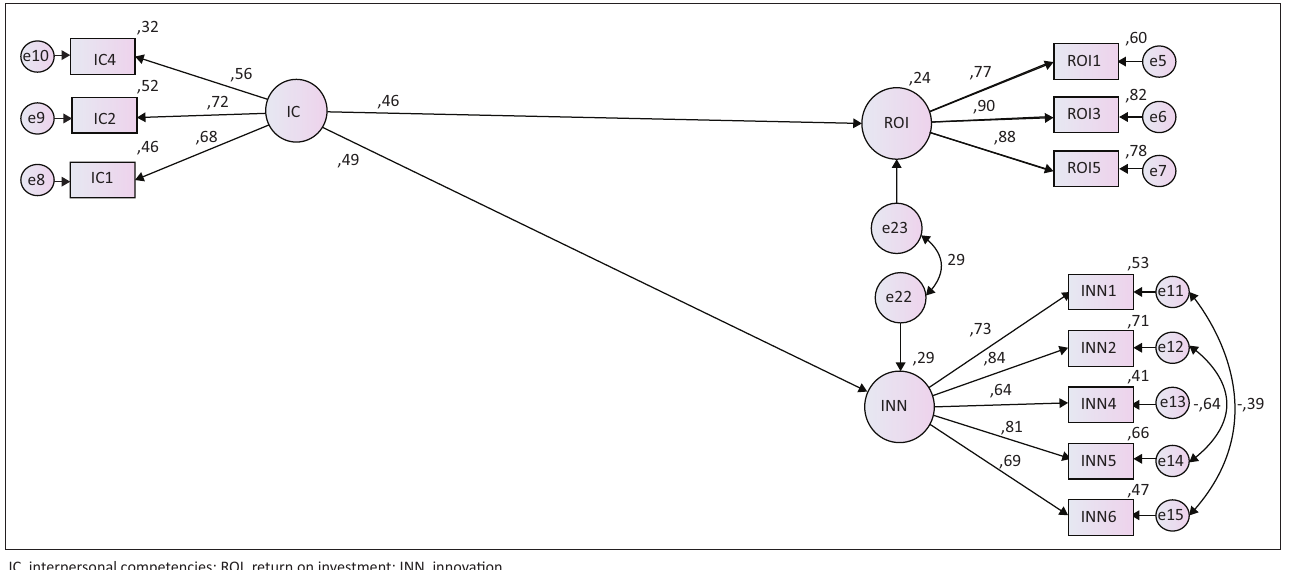
FIG URE 2: The structural TABLE 5: Results for each hypothesised relationship. Relationships Regression weights